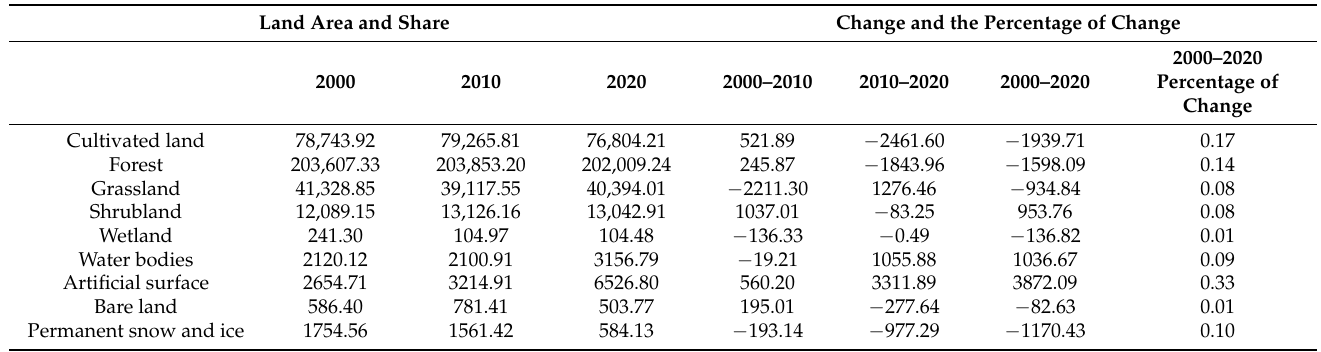
Table 3. Land use changes in the study area from 2000–2020 (km 2 /%).